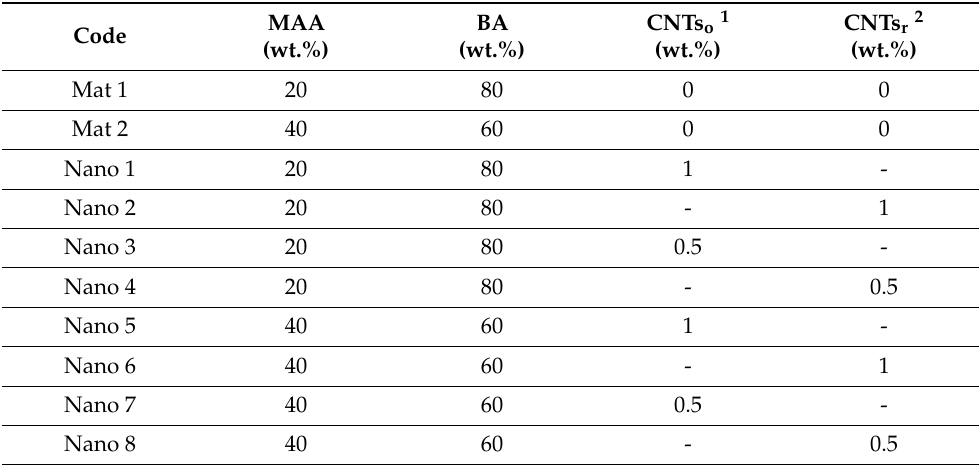
Table 1. Content of MAA, BA, CNTs o , or CNTs r used for the preparation of pure MAA–BA copoly- mers, as well as the CNTs o-OCl-MAA –BA or CNTs r-OCl-MAA –BA nanocomposites. MAA BA CNTs o 1 Code (wt.%) (wt.%) (wt.%) Mat 1 Mat 2 40 Nano 1 20 80 Nano 3 20 Nano 4 20